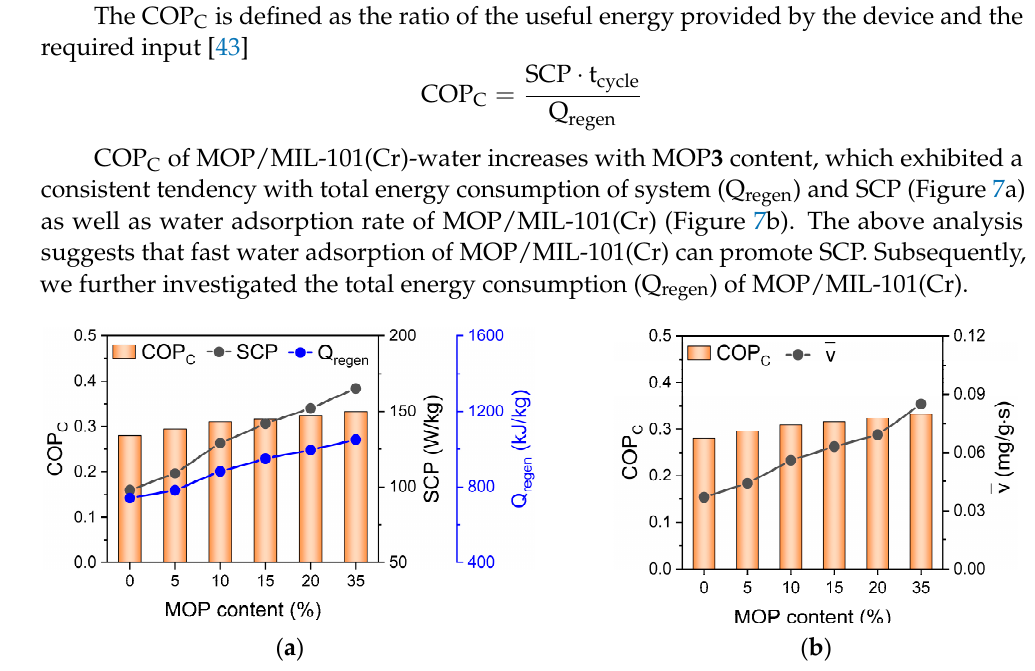
Figure 7. Relationship between ( a ) SCP, total energy consumption (Q regen ), ( b ) water adsorption rate ( v ), and COP C of MOP/MIL-101(Cr)-water working pairs at different MOP 3 content. Total energy consumption (Q regen = Q ad + Q w + Q hex + Q des ) of ACS is composed of four parts based on the energy balance in the adsorption bed (Equation (1)): energy consump- tion by temperature rising (from adsorption temperature to desorption temperature) of adsorbents or sensible heat of adsorbents (Q ad = C p,ad (T des ‒ T ads )), the sensible heat of adsorbed water (Q w = v · t o · C p,w ( T des − T ads ) ) and the sensible heat of heat exchanger (Q hex = M hex C p,hex ( T des − T ads ) ) during desorption process, and energy consumption for water desorption (Q des = ∆ q t · q st ). It is noted (Figure 8) that the Q hex is a constant at the fixed temperature and mass of adsorbents. The sensible heat of MOP/MIL-101(Cr) (Q ad ) and adsorbed water (Q w ) are mainly affected by the heat capacity of MOP/MIL-101(Cr) (C p,ad ) and water adsorption rate, respectively. The slight increase in Q ad with the MOP 3 content can be ascribed to the increased heat capacity of MOP/MIL-101(Cr) upon MOP 3 (C p,ad = 1.77 J/g · K for MOP 3 , Table 1). Q w was also slightly improved because of the increased water adsorption rate of MOP/MIL-101(Cr) with MOP 3 content. In contrast, the energy consumption of water desorption (Q des ) mostly contributes to total energy consumption (Figure 8a), which is ascribed to the significantly increased hydrophilicity of MOP/MIL-101(Cr) upon MOP 3 encapsulation that requires the increased energy consump- tion for desorption. In addition, the increased heat of adsorption (q st , Table 1) and cyclic working capacity of MOP/MIL-101(Cr) resulting from fast water adsorption also favor the remarkable increase in Q des (Figure 8b). In conclusion, the improved water adsorption rate promotes SCP of MOP/MIL-101(Cr)-water working pairs, resulting in the signifi- cant enhancement of SCP. Energy consumption of MOP/MIL-101(Cr) can be enhanced by increased cyclic working capacity and heat of adsorption, which is not beneficial for improving COP C . Nonetheless, the improved SCP caused by accelerated water adsorption contributes to the enhancement of COP C . Thus, the COP C of MOP/MIL-101(Cr)-water working pairs increased with MOP 3